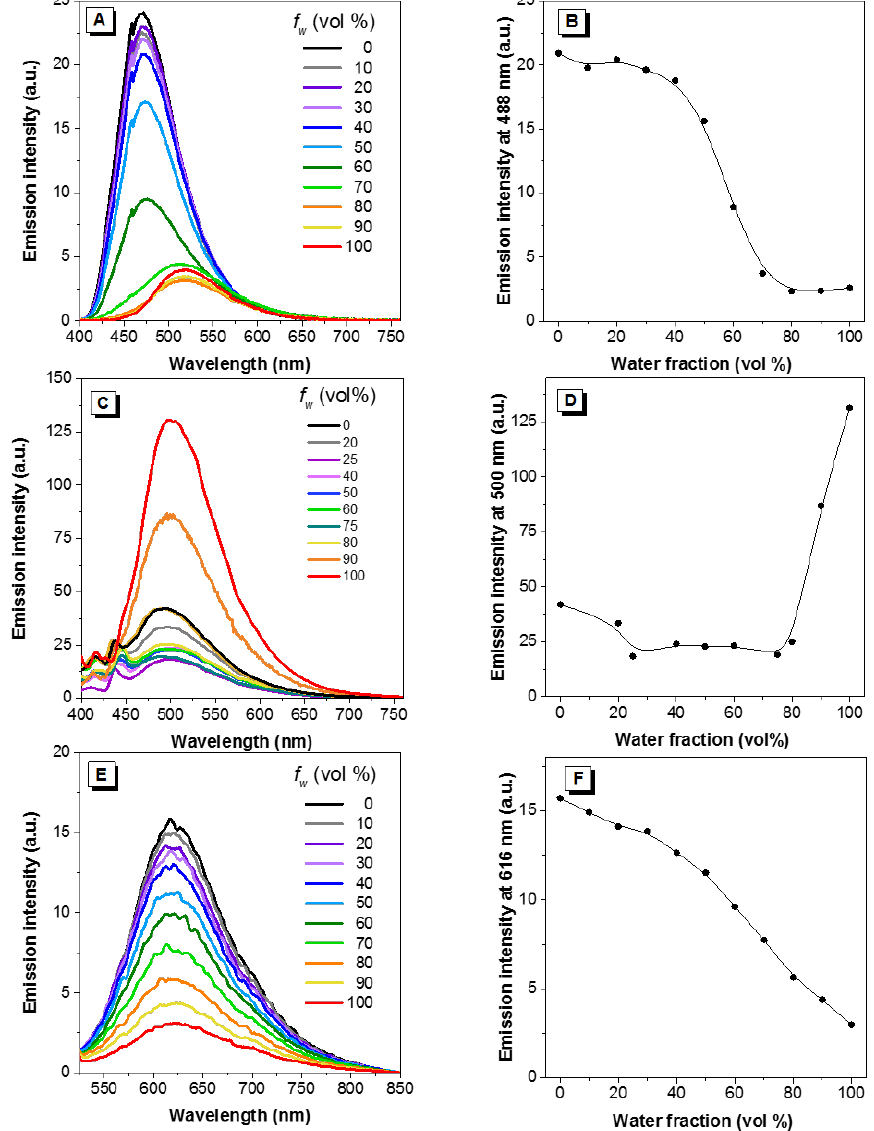
Figure 8. Emission intensity of dyes 1 ( A , B ), 2 ( C , D ) and 3 ( E , F ) in methanol/water mixtures with different water fractions. Concentration = 10 µM. f w and vol% = water fraction. λ ex : 385, 387 and 437 nm different water fractions. Concentration = 10 µ M. f w and vol% = water fraction. λ ex : 385, 387 and respectively. 437 nm